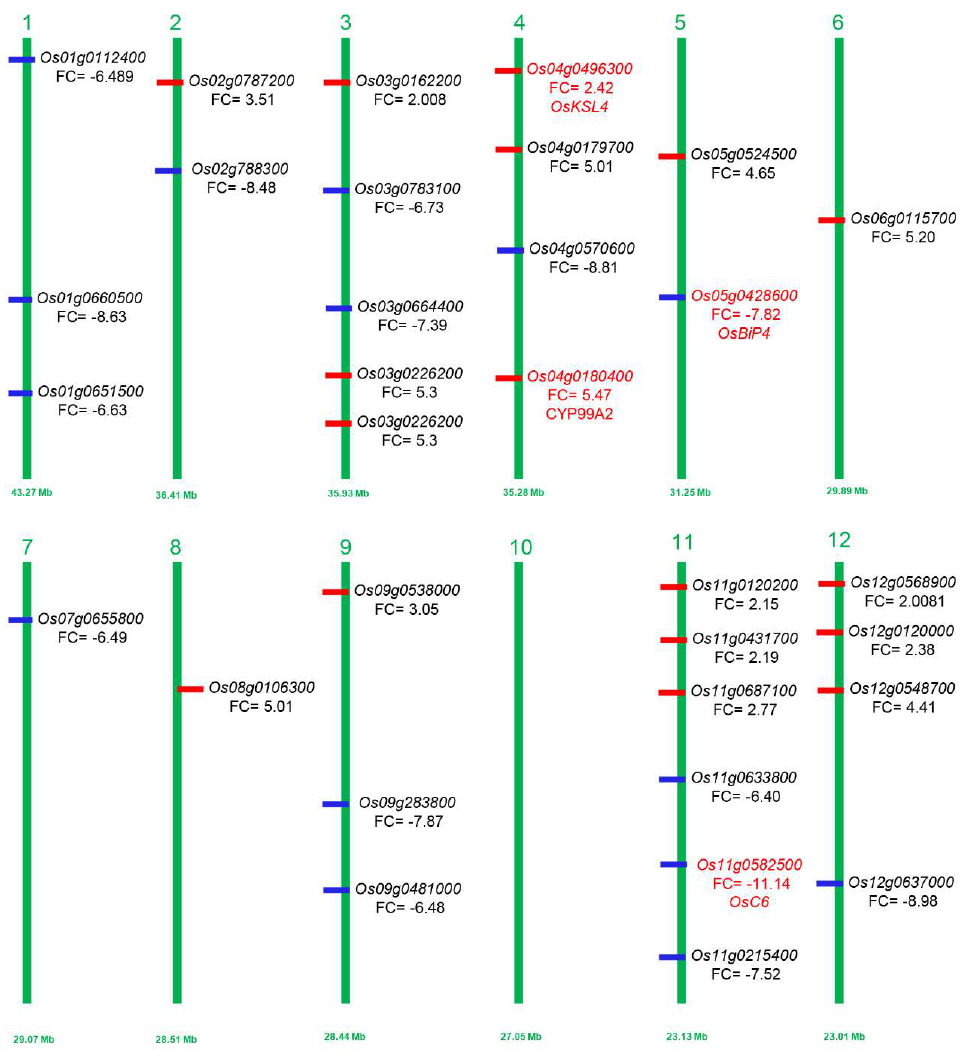
Figure 5. Visualization of predicted genes possibly involved in inflorescence development and panicle abortion. Downregulated and upregulated DEGs in apa1331 are mentioned in blue and red colors, respectively. Perviously cloned and uncloned genes are mentioned in red and black text, respectively. The numbers 1–12 represent the number of chromosomes of